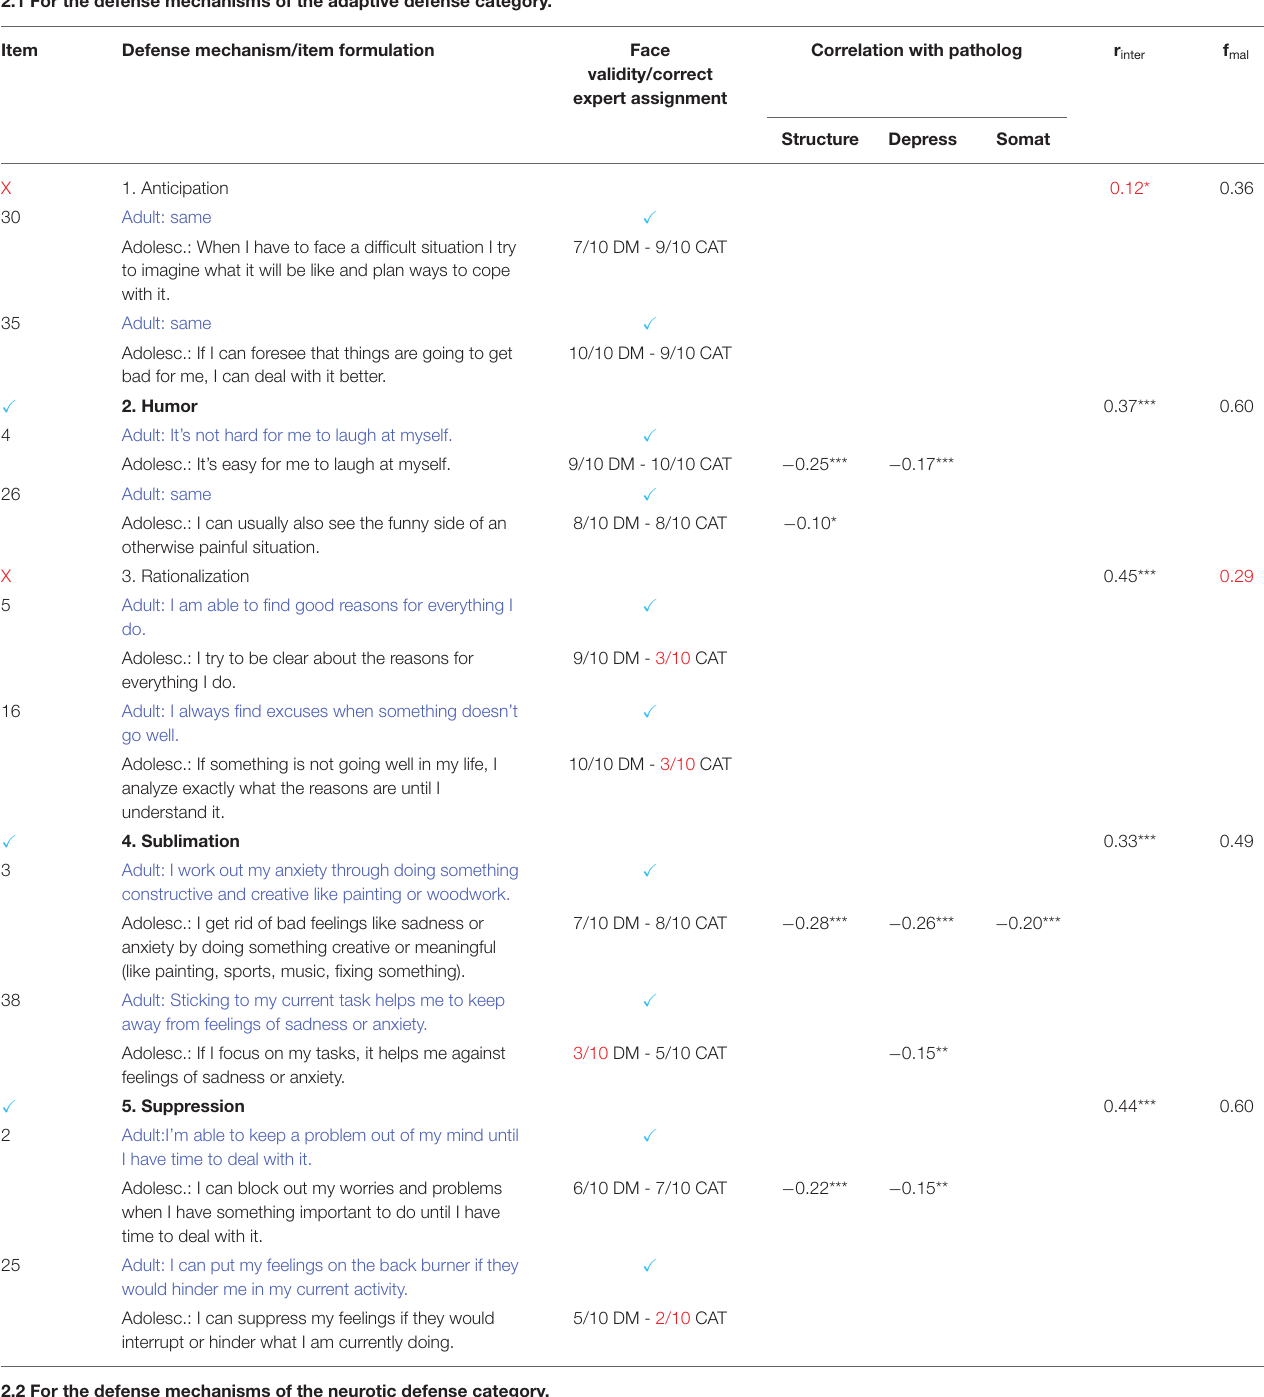
TABLE 2 | DSQ 40 item formulations for adolescents and results for (A) face validity by expert assignments ( N = 10, therapists) and for (B) construct validity and reliability by empirical survey ( N = 403, adolescents). Comparison to the original item formulations for adults (28) and to results of expert assignments for adults (28, 29). 2.1 For the defense mechanisms of the adaptive defense